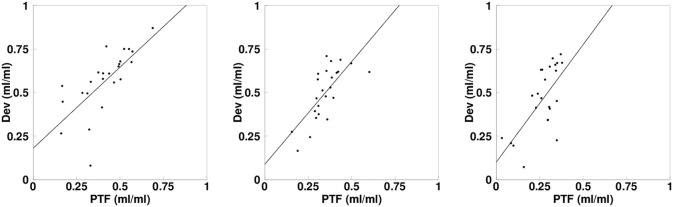
Linear regressions depicting the correlation between the perfusable tissue fraction (PTF) and the extravascular tissue density (Dev) values for LV (L), septum (S), and RV (R). The solid lines show the regressions.